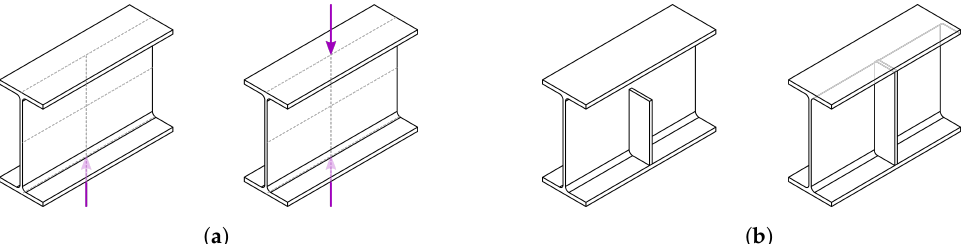
Figure 6. ( a ) Treated load cases and the ( b ) conventional design solution for partial and full